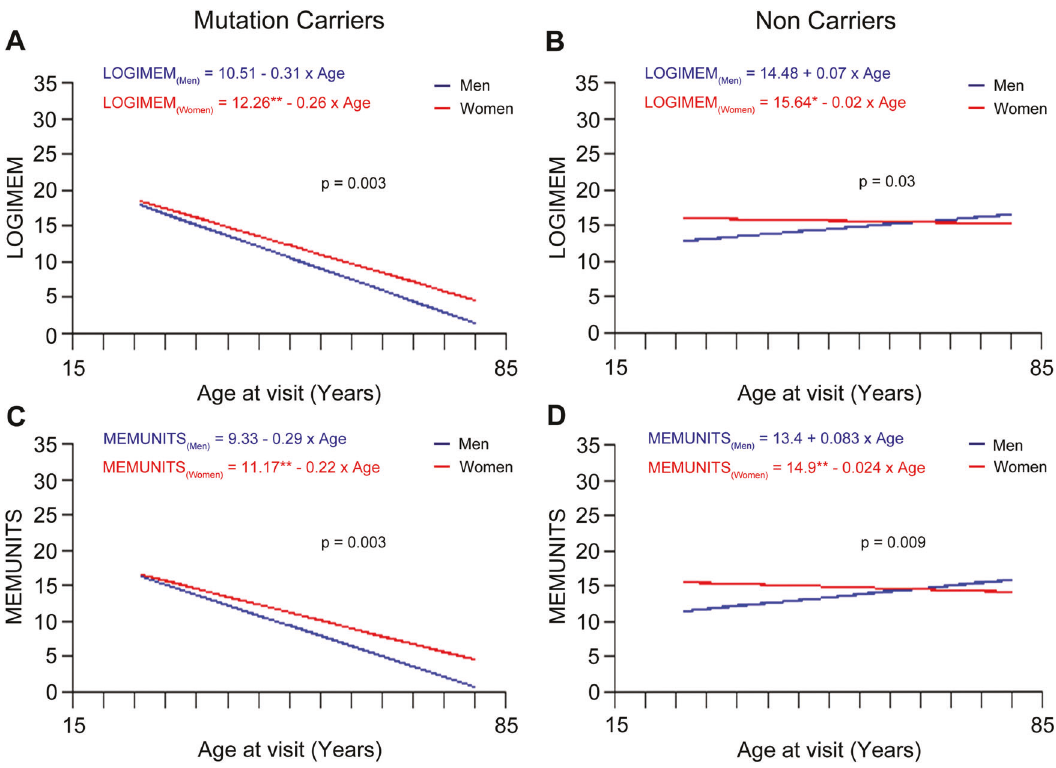
Fig. 5 Performance on Wechsler ’ s logical memory test in men mutation carriers as compared to women mutation carriers. A The linear regression trend lines from linear mixed effects models for longitudinal data on Wechsler ’ s logical memory test score with age (immediate recall, LOGIMEM) from women and men participants in the mutation and non-carriers groups. Performance in the LOGIMEM test was signi fi cantly better in women mutation carriers compared to men mutation carriers suggesting that overall performance of women is signi fi cantly higher than men irrespective of the age of entry in the study (men equation, y = − 0.306 × age + 10.51; women equation, y = − 0.258 × age + 12.266; men vs women, p = 0.003). B Performance in the LOGIMEM test was also signi fi cantly higher in women compared to men in non-carriers, but regression lines are different, suggesting that overall performance of women is statistically signi fi cant than men subjects irrespective of the age of entry in the study (men equation, y = 0.068 × age + 14.478; women equation, y = − 0.016 × age + 15.643; men vs women, p = 0.03) C Performance in the MEMUNITS test was signi fi cantly higher in women compared to men mutation carriers suggesting that overall performance of women is signi fi cantly higher than men irrespective of the age of entry in the study (men equation, y = − 0.289 × age + 9.33; women equation, y = − 0.223 × age + 11.163; men vs women, p = 0.003). D Intercept of the performance in the MEMUNITS test was signi fi cantly higher in women versus men in non-carriers (men equation, y = 0.083 × age + 13.392; women equation, y = − 0.024 × age + 14.899; men vs women, p = 0.0091). The p -value is for the interaction term of